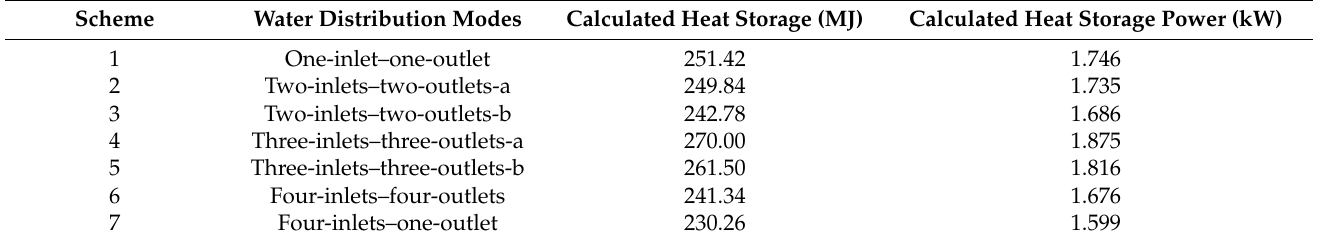
Figure 21. The influence of water distribution mode on the guaranteed operation time of reservoir. Further analysis of the numerical model shows that there are still some calculation errors between the different water distribution modes, which is the same as in the study of the geometric size change of the phase change heat storage module. This refers to the fact that there are errors when calculating the heat storage quantity by the water, the surface and the phase change heat storage module. This leads to the difference in calculating the heat storage power. Different heat storage quantities and their power are calculated by various water distributions, which can be seen in Table 11. The calculated heat storage and e power values of each working condition in the table are the values obtained by simulating for 40 h. Table 11. Calculated heat storage and calculated heat storage power corresponding to different water distribution